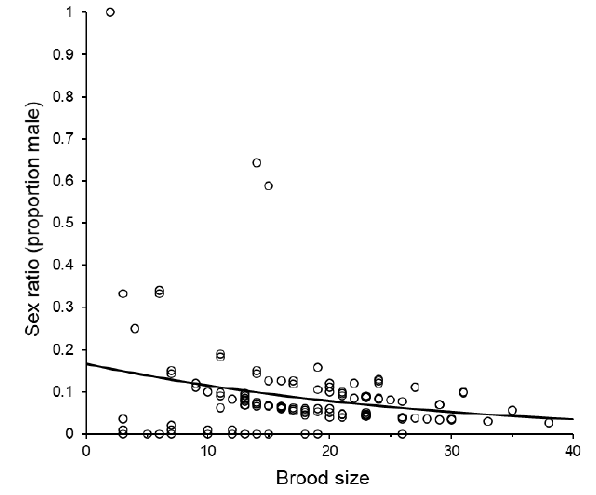
Figure 9. Sex ratios of broods produced by groups of Sclerodermus brevicornis females in relation to the size of the brood. Some data points were vertically displaced from their exact proportions to reduce overlap and illustrate sample sizes. The fitted curve was estimated using logistic regression and (estimated probability = 1/(1 + (1/(antiLog e (( − 0.0427 × brood size) − 1.616))))).